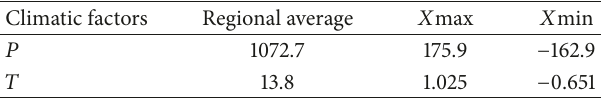
Table 8: Regional feature characteristics statistics.